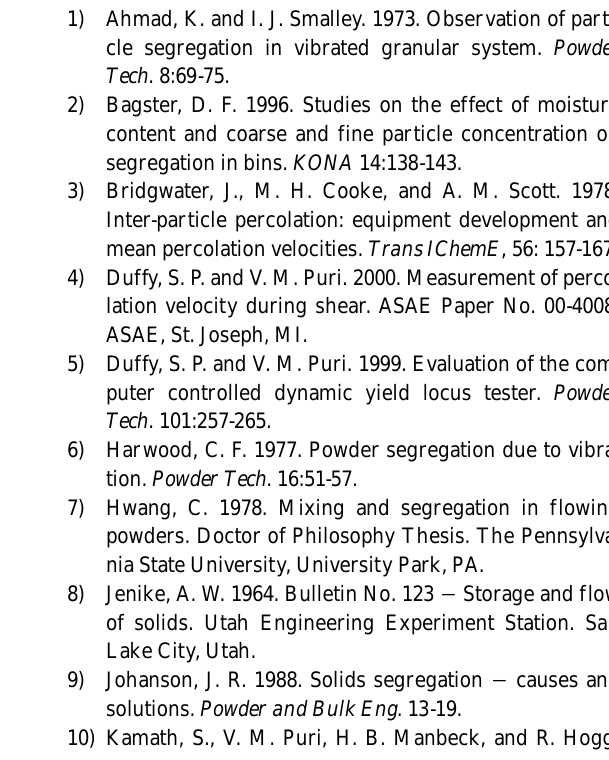
10.9:1, the amount of input energy was critical because the size of the fine particles was near the size of the coarse bed pore space. When the input energy was below a critical limit, mechanical arch- ing was occurring. Although the input energy is a function of bed depth and cycle speed, these para- meters did not influence the results outside ran- dom behavior. 3. The percolation of fines through a bed of coarse particles was isotropic. There was no observed bias in the collection pan at the end of the tests. 4. Significant differences (p (cid:2) 0.05) were measured between individual load cells under different treat- ments in one out of six treatments. Many treat- ments were not significantly different (p (cid:7) 0.05). However, when statistical comparisons were made in the effective percolation direction, differences (p (cid:2) 0.05) were significant when comparing the size ratios of 10.9:1 and 8.7:1 to the size ratio of 5.1:1.